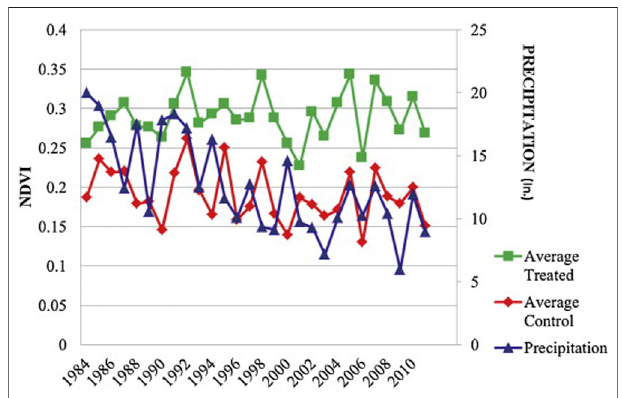
FIGURE 3 | Average NDVI plotted over time in San Bernardino (CLO) at treated and control sites, in relationship to annual precipitation (reprinted from Norman et al., 2014).